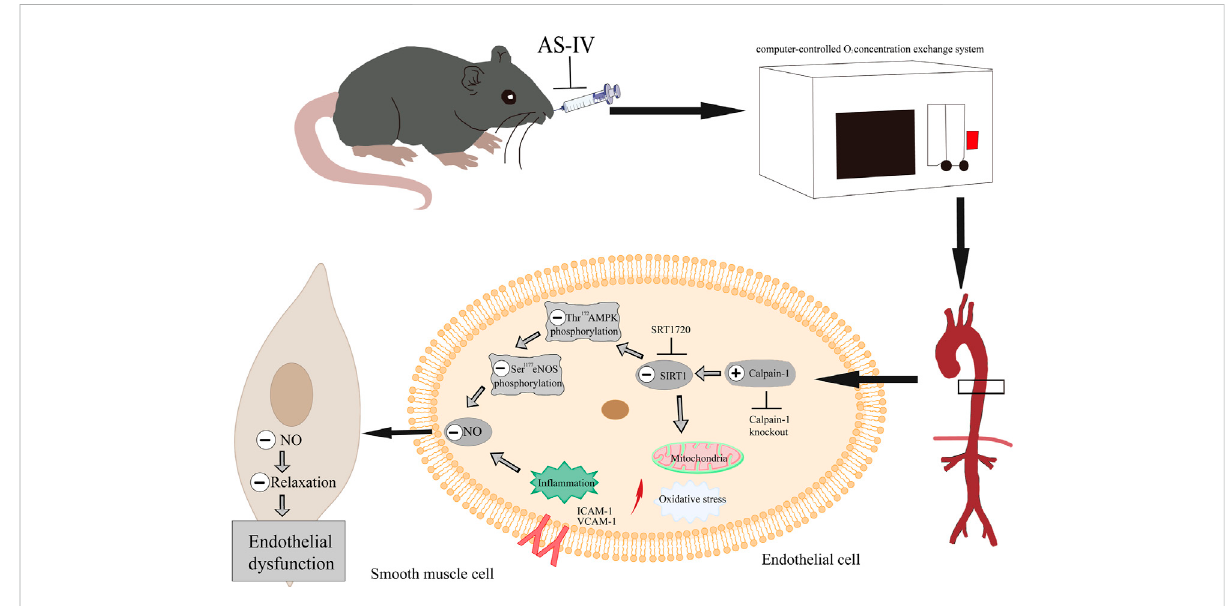
FIGURE 10 As-IV ameliorates endothelial dysfunction induced by chronic intermittent hypoxia through the calpain-1/SIRT1/AMPK signaling